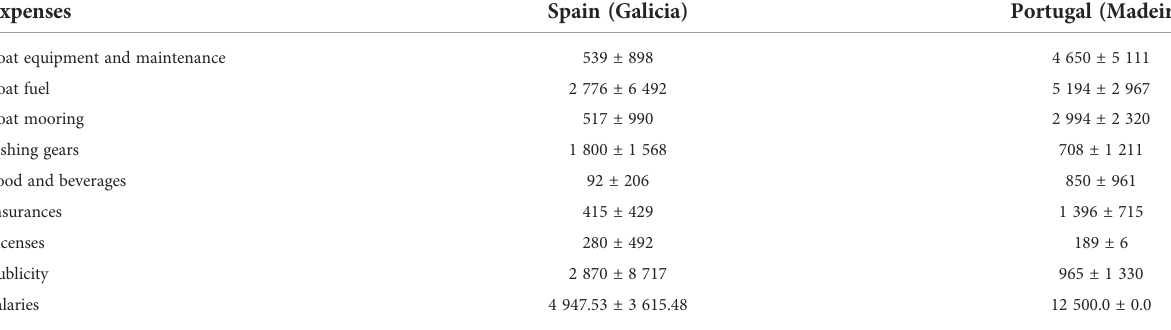
TABLE 2 Mean (and SD) annual expenses and investments ( € ) of recreational fi shing charter boat companies operating in Spain (Galicia) and Portugal (Madeira archipelago).